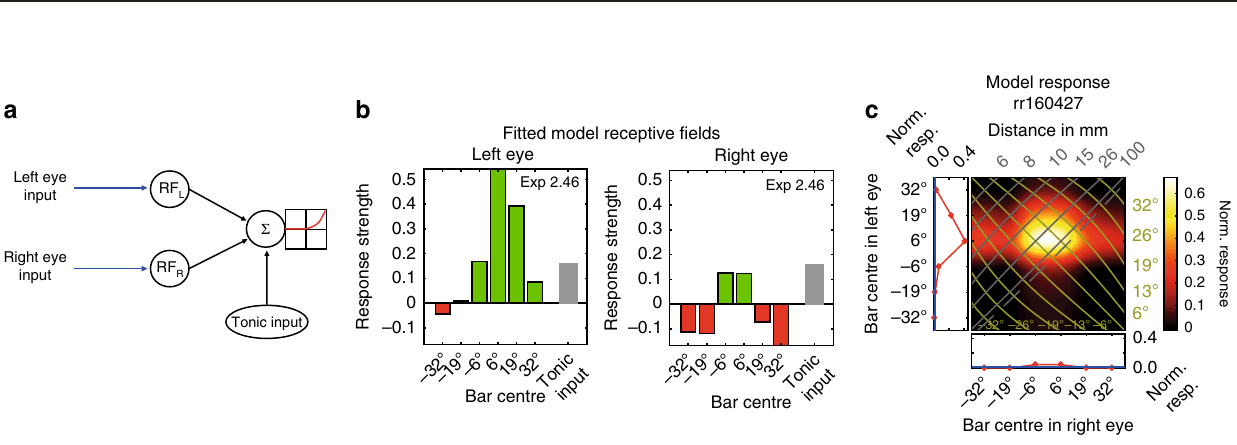
Fig. 1 Experimental setup and disparity-sensitive TAOpro-neuron. a Praying mantis watches computer screen showing disc stimulus during neuronal recording (side view, top view). Spectral fi lters ensure each eye sees only one disc; lines of sight in blue (green) for left (right) eye. Virtual disc fl oats in front of screen (red line). b Mantis brain with major neuropils. Inset 3D-reconstruction of lobula complex (LOX), site of rami fi cations of all except one neuron type presented in this study. AL antennal lobe, ALO-D dorsal unit of the anterior lobe, ALO-V ventral unit of anterior lobe, CX central complex, LA lamina, MB mushroom bodies, ME medulla, OLO1/2 outer lobe 1/2, SLO stalk lobe. c Reconstruction of TAOpro-neuron (tangential projection neuron of the anterior and outer lobes) showing rami fi cations in LOX and central brain. Inset: left brain, colour shows LOX sub-compartments containing rami fi cations. d Disc trajectory. Red dots: disc centre at 60 Hz refresh rate. e TAOpro-neuron responses to disc stimulus. Sketches indicate stimulus disparity. Upper lanes: vertical (blue) and horizontal (red) distance of disc from screen centre; negative values are left and lower side of screen. Middle lanes raster plots, lower lanes spiking rates (average red line, ±1SEM) after Gaussian smoothing (SD 150 ms). Right plot: virtual disc at 25 mm (in catch range), left: control (right and left eye disc swapped). f Bar stimulus con fi guration with all 6 different bar positions on computer screen in 100 mm distance to animal (shown alternating dark/bright red for clarity; right panel zoom) and virtual bars (see also Supplementary Fig. 1 for further explanation). Azimuthal direction of simulated bars from mantis head midline in olive and distance isolines in grey. g Monocular and binocular responses to bar stimulus. Binocular responses as pseudocolour 2D-plot and monocular responses (averages ±1SEM; blue line background activity) as 1D-plots at left and bottom margins for respective eye. Axes show centre of bar shown to left and right eye, respectively. Binocular response is interpolated (raw plot in Supplementary Fig. 2). Isolines indicate azimuth (olive) and distance (grey) from mantis as shown in f . Dashed line marks screen locations implying objects at “ in fi nity ” (parallel lines of